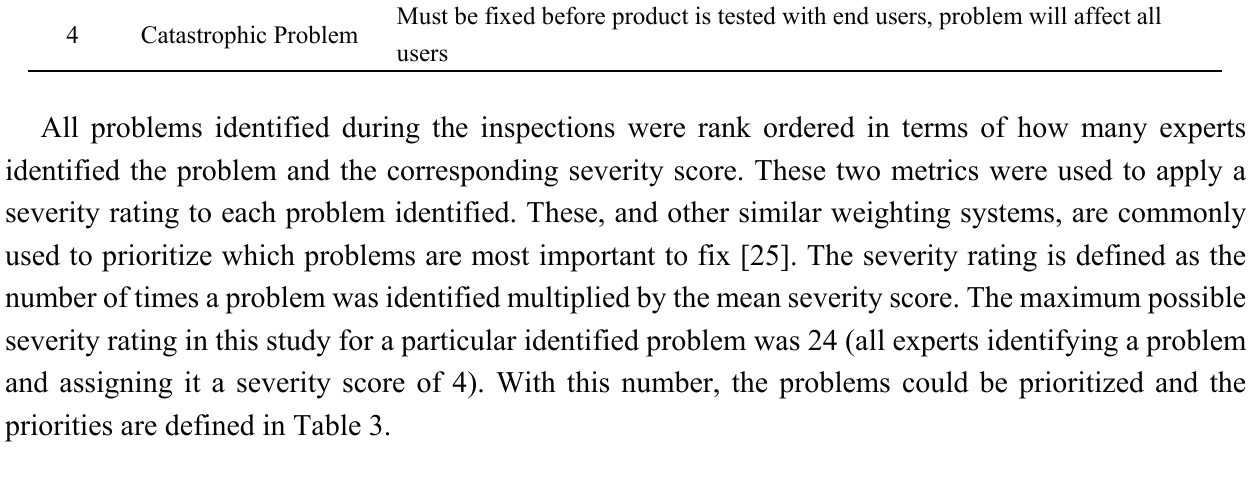
Table 3. Showing how total severity ratings are used to categorize problems based on priority.